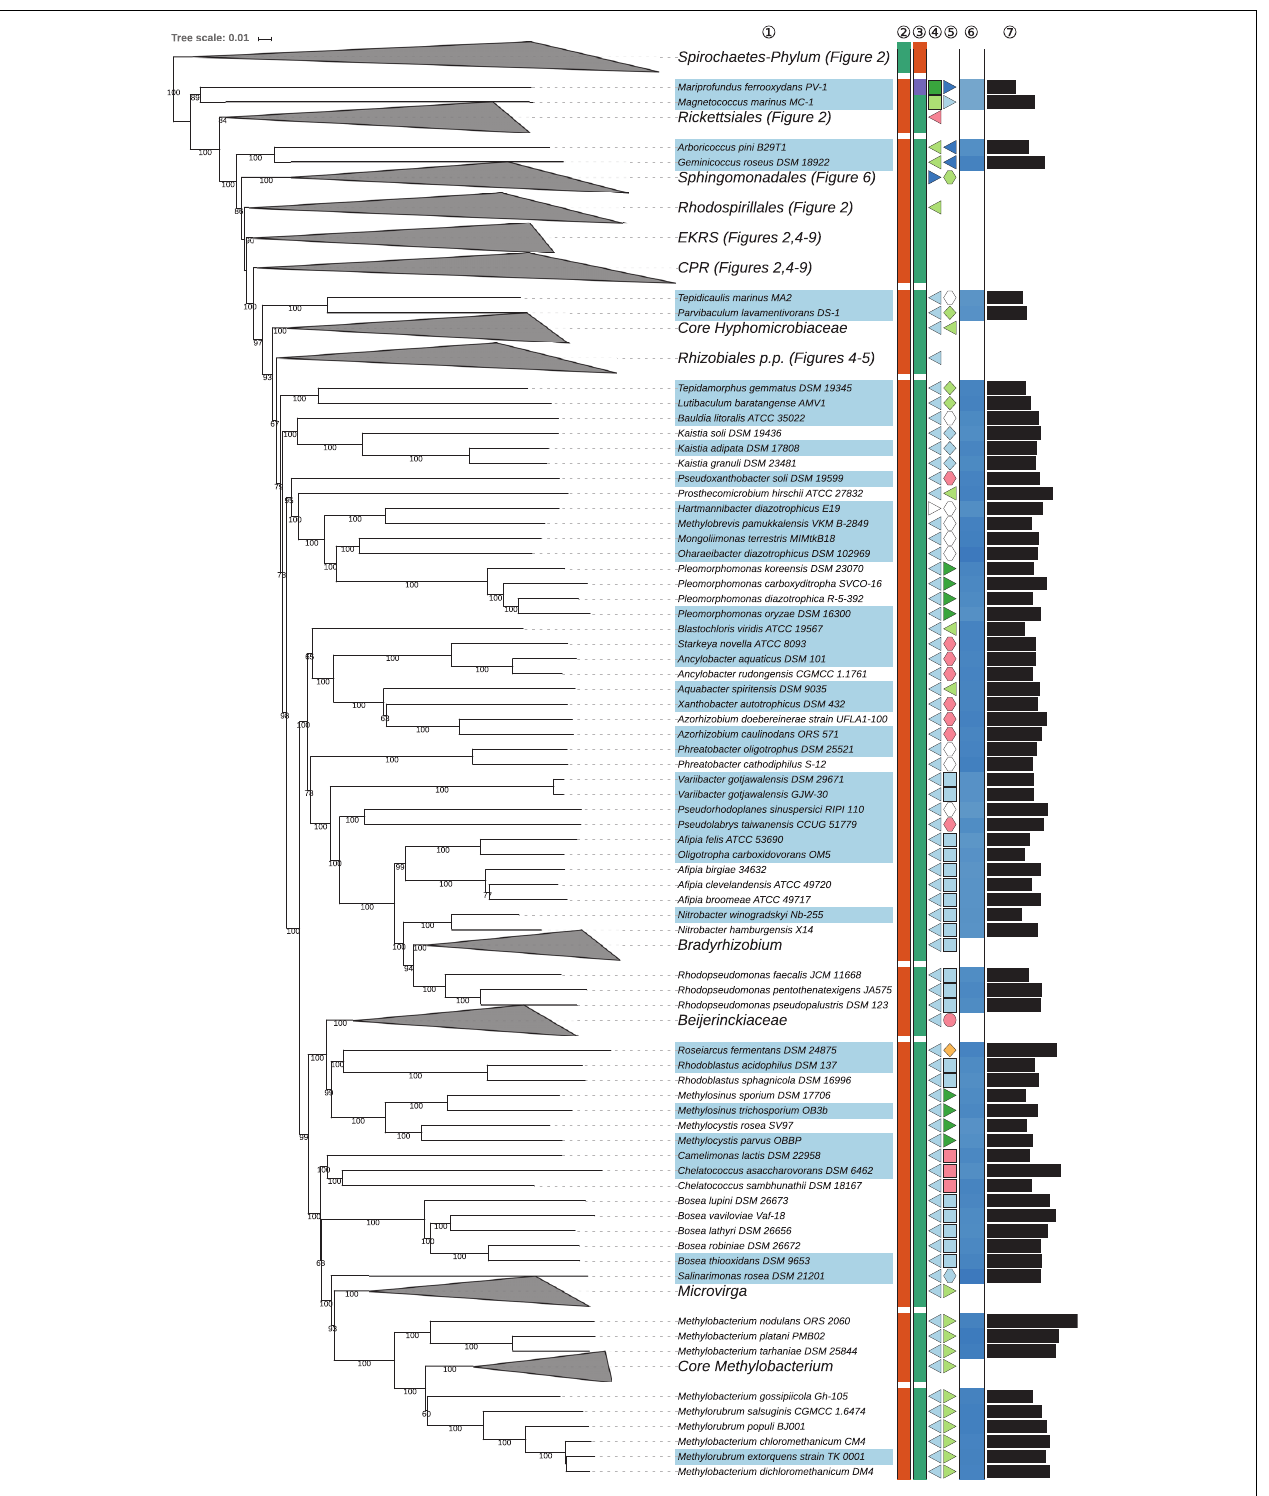
FIGURE 3 | Second part of the GBDP tree shown in Figure 1 , focussing on parts of Rhizobiales ( Hyphomicrobiales ). The clade labeled EKRS comprises the orders Emcibacterales, Kordiimonadales, Rhodothalassiales, and Sneathiellales , whereas CPR denotes the clade including the orders Caulobacterales , Parvularculales, and Rhodobacterales , details for which are shown in the subsequent figures. Tip labels with light-blue background indicate type species of genera, colors and symbols to the right of the tips indicate, from left to right, phylum, class, order and family; for details and abbreviations see Figure 1 . The blue color gradient indicates the G+C content as calculated from the genome sequences, followed by black bars indicating the (approximate) genome size in base pairs.